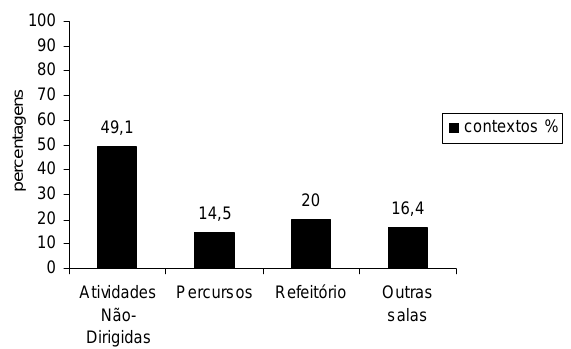
Figura 1. Percentagem de narrativas intraconversacionais